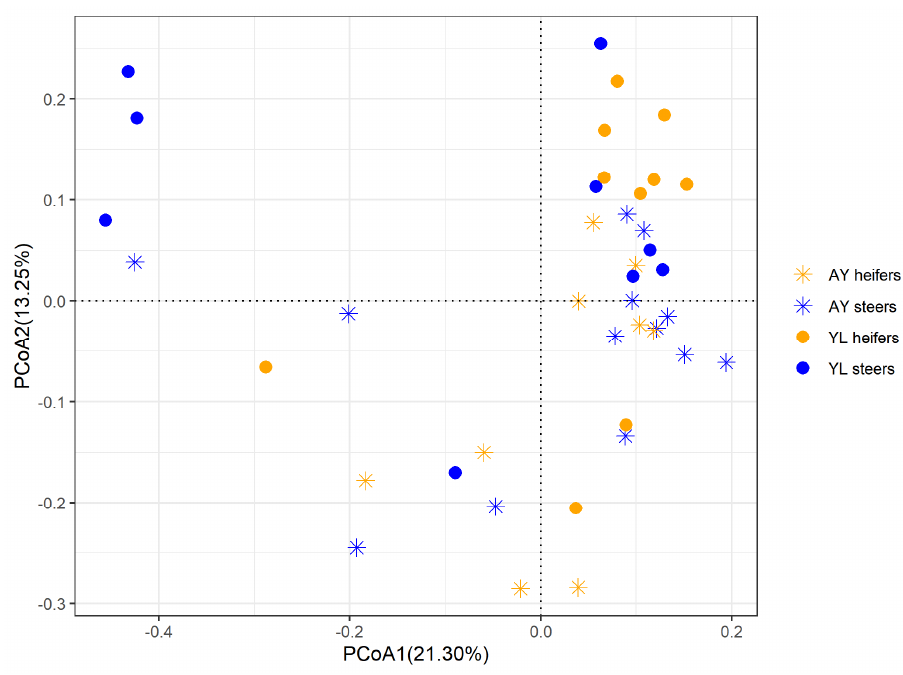
Figure 1. Principal coordinates analysis (PCoA) plot based on Bray-Curtis dissimilarity matrix to compare the bacterial structure among Angus × Yiling (AY) heifers, AY steers, Yiling (YL) heifers, and YL steers. Table 5. Relative abundance of the dominant phylum with an average relative abundance ≥